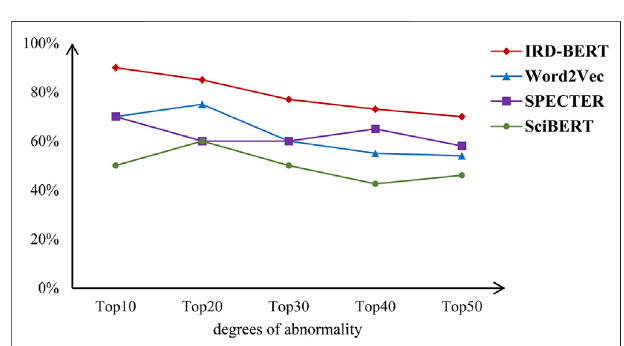
FIGURE 3 | The proportion of vectors from interdisciplinary